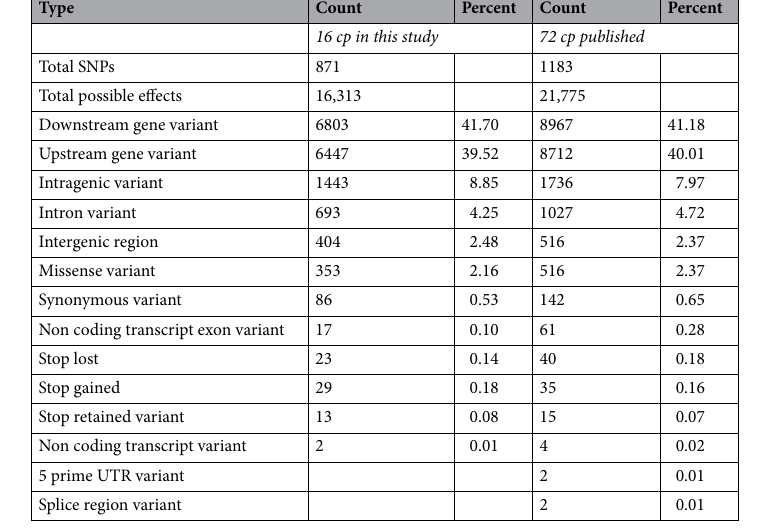
Table 2. SNP detection and annotation based on the consensus sequences of the 16 and 72 chloroplast genomes of the Triticum–Aegilops complex using SnpEff 47 . Note that the gene regions defined in SnpEff annotation differ from those four regions of cp genome structure (LSC, SSC, IRb and IRa). Up/Downstream gene means the distance to the first/last codon of the gene; Intergenic region mean the distance to the closest gene; and Splice region means the region of the splice site, either within 1–3 bases of the exon or 3–8 bases of the intron.